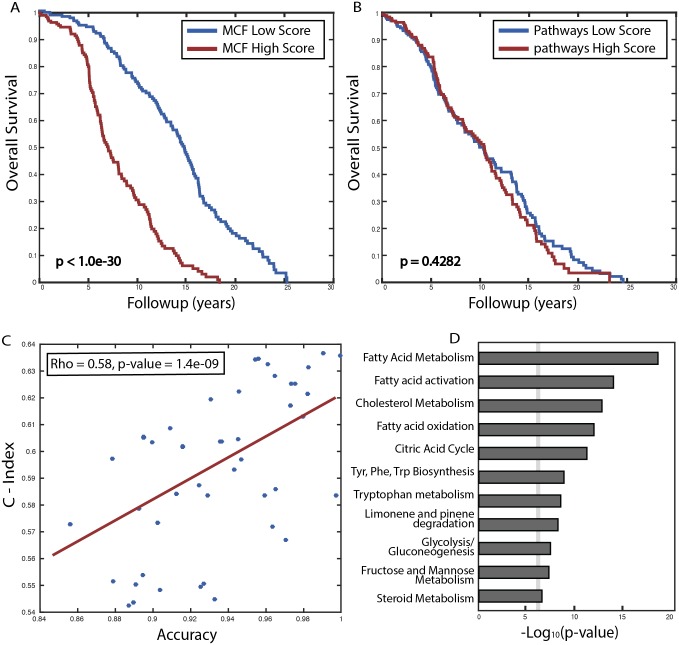
MCF pathway utilization predicts the survival of breast cancer patients, while canonical pathways show no such signal.Shown in (A) and (B) are the Kaplan-Meier survival curves for patients predicted by MCF and canonical pathways respectively to have the best and worst prognosis (top and bottom 10% of patients scores, respectively; Methods). (C) A scatter plot showing the correlation between the prediction classification accuracy achieved using each individual MCF pathway in the combined breast cancer data from TCGA and GEO (where they are identified) (X-label) and the C-index obtained using each such pathway in predicting patients’ survival on the (unseen) METABRIC data. (D) The canonical pathway enrichment of the reactions participating in the MCF composite pathways predictive of survival. The dashed line represents a significance threshold of 0.05 (corrected for multiple hypotheses testing).